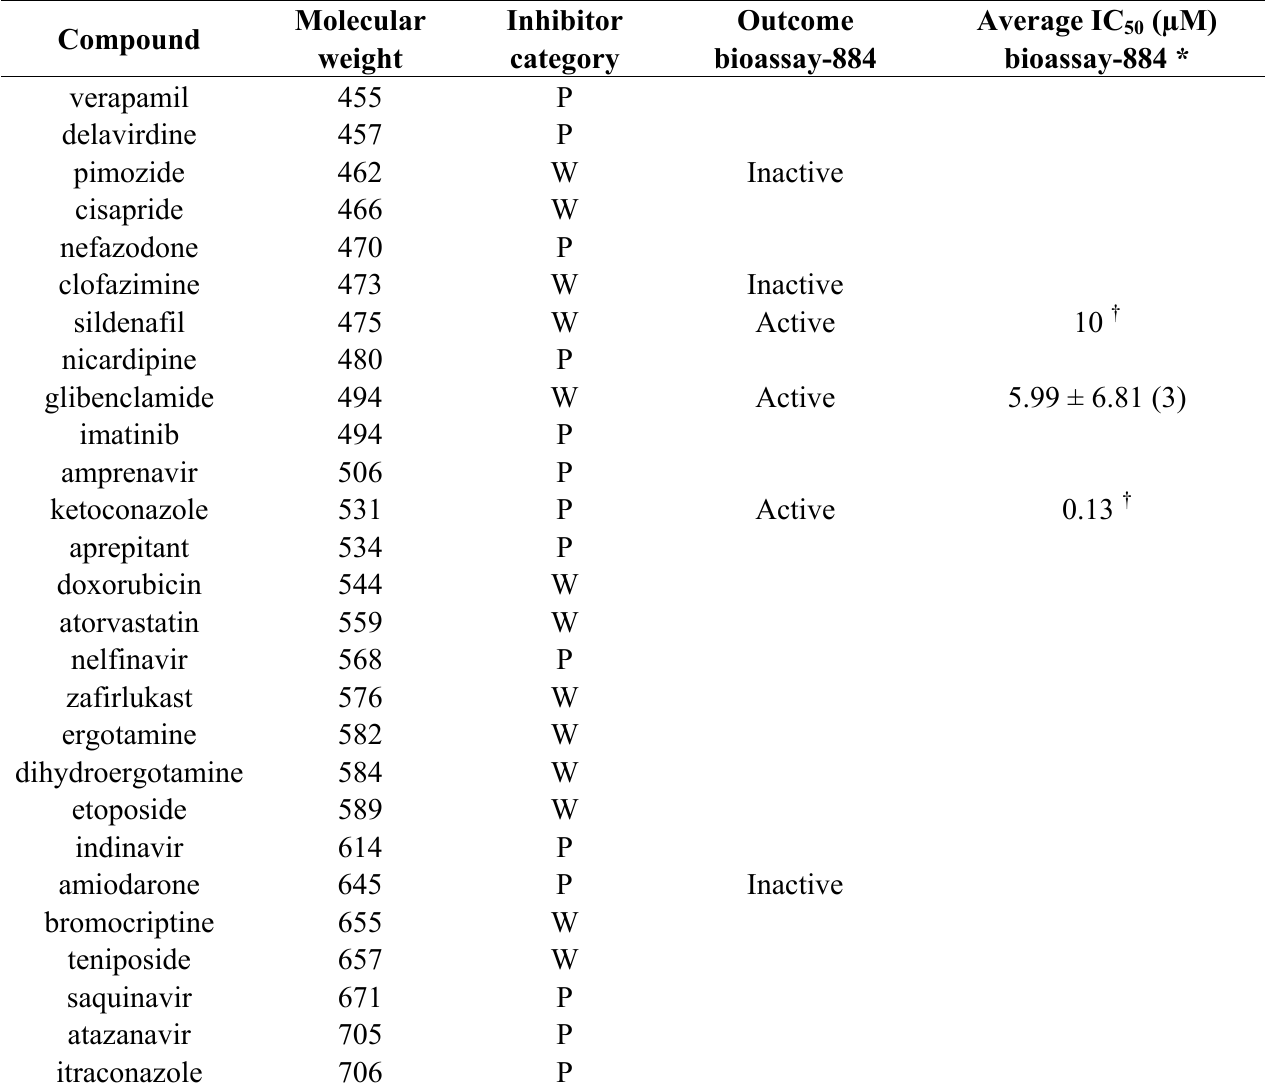
Table 6. Training set of potent (P) and weak (W) inhibitors of CYP3A4 in the high-MW band.